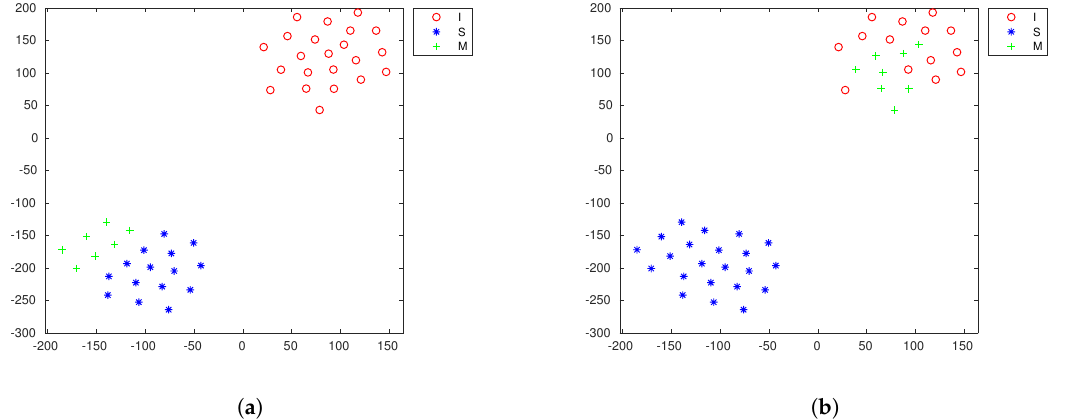
Figure 9. t-SNE visualized histogram features clustered. ( a ) Example of desirable cluster; ( b ) Example of undesirable cluster.